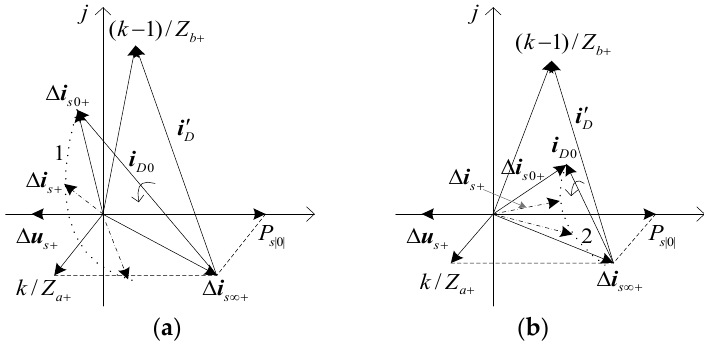
R ; and ( b ) large cb